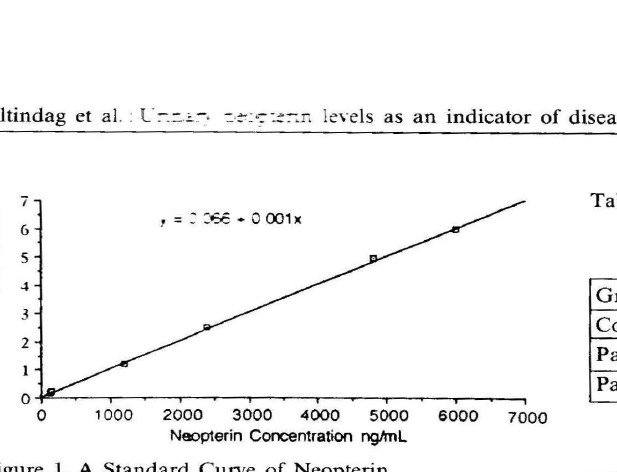
Figure l. A Standard Curve of Neopterin and monitored its native fluorencence (353 nm exi tation, 438 nm emission). The retention time of stan dard neopterin was determined to be about 4.5 minutes. The qualification and quantification of